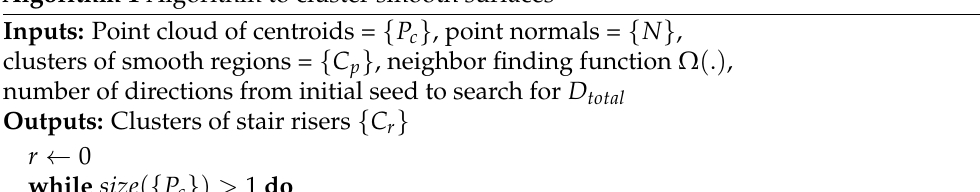
Algorithm 1 Algorithm to cluster smooth